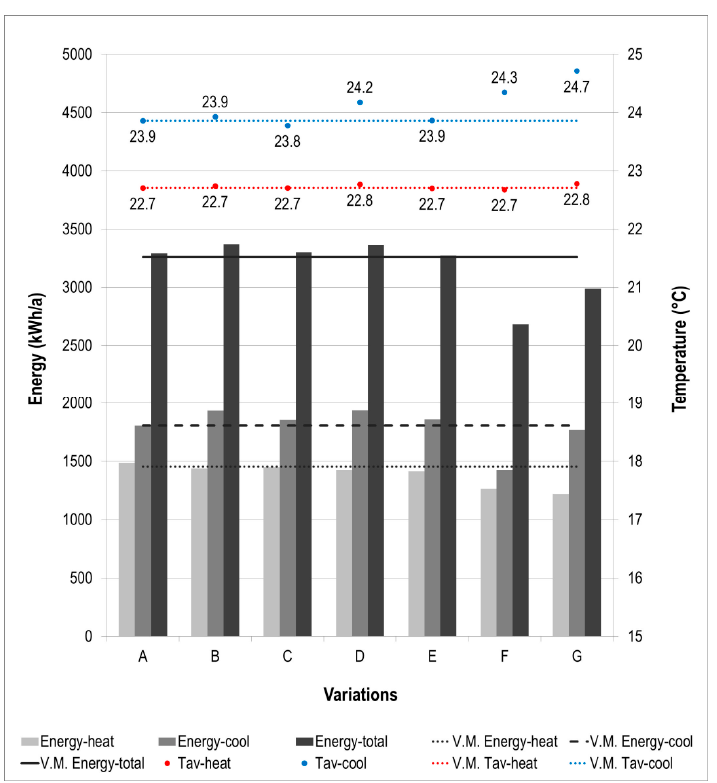
Figure 3. Simulated energy and indoor air temperatures for variations without a specific parameter in comparison with validated model (V. M.): A—without large internal gains; B—without extraction of energy with exhausted air; C—without insufficient energy supply for cooling; D—without window opening by occupants; E—without use of internal roller blinds; F—without temperature adjustments using regulators; and G—without all six specific parameters.